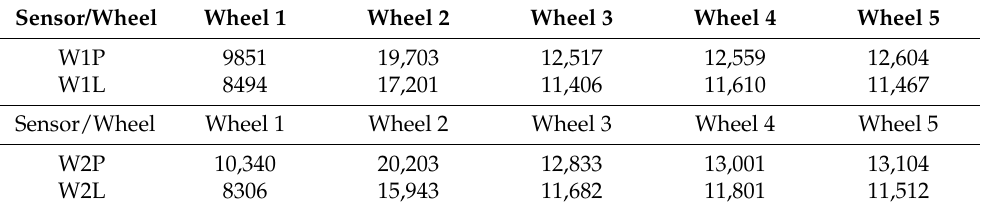
Table 13. Strain gauge sensor signal characteristics—signal amplitude (ADU). Sensor/Wheel